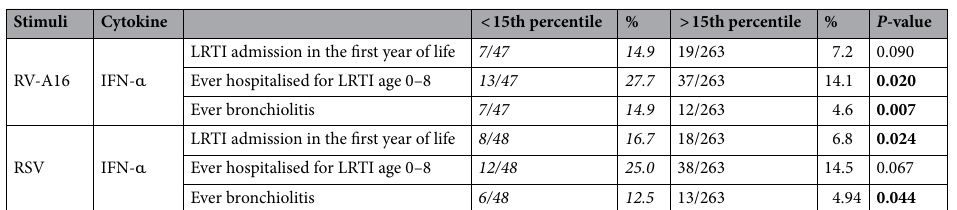
Table 4. Comparisons of LRTI and bronchiolitis hospital admissions in participants with IFN-α responses to RV-A16 and RSV below and above the 15th percentile of the entire cohort. Differences were assessed using χ 2 tests. P values less than 0.05 are in bold. The group with the higher frequency of LRTI hospital admissions and bronchiolitis cases in early life is highlighted in italic.